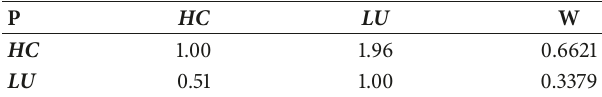
Table 10: Comparison for functional grade node.